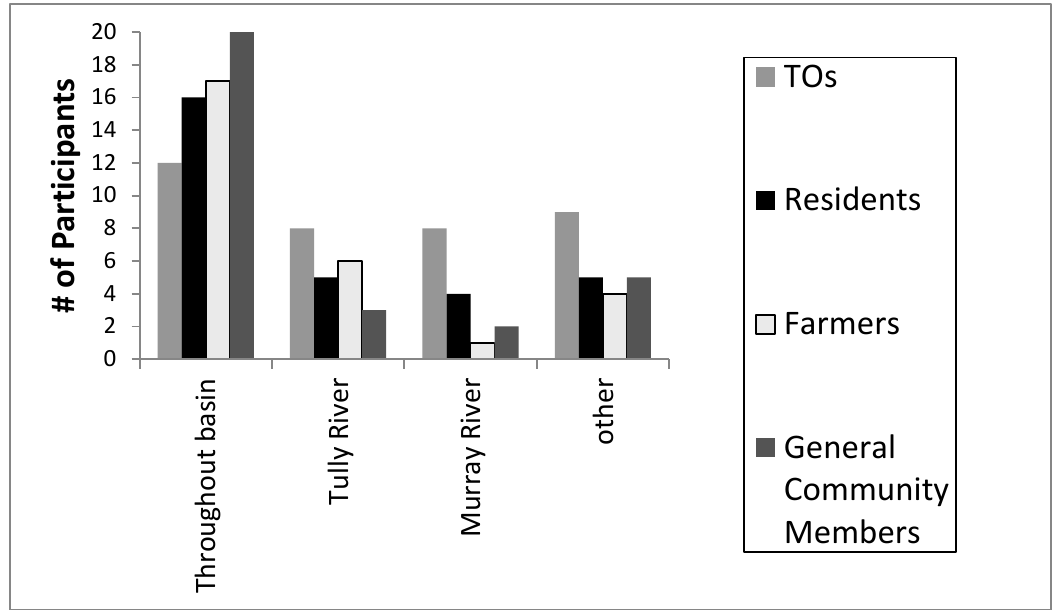
Figure A13. Suggestions for sampling locations in the basin.